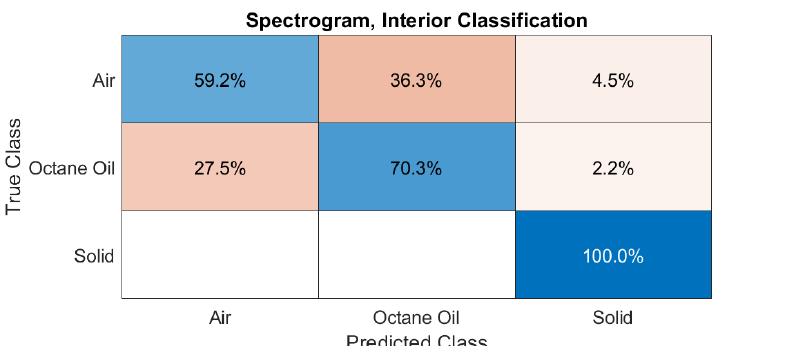
Figure 6. Confusion matrix for the CNN trained to classify interior material (air, octane oil, or solid) with the highest classification accuracy. The network was trained using the spectrogram representation with a 20 dB SNR, resulting in a 78.58% average overall accuracy (Table 10). This network consisted of one convolutional layer with nine feature maps per layer (Table 5). The blue boxes indicate correct classification while the orange boxes indicate incorrect classification.